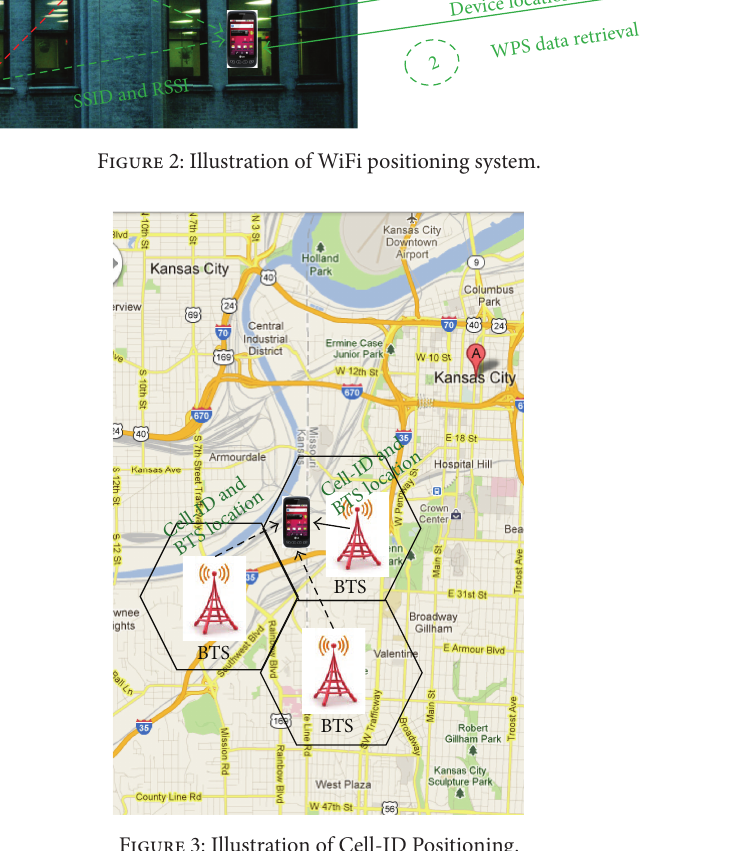
Figure 3: Illustration of Cell-ID